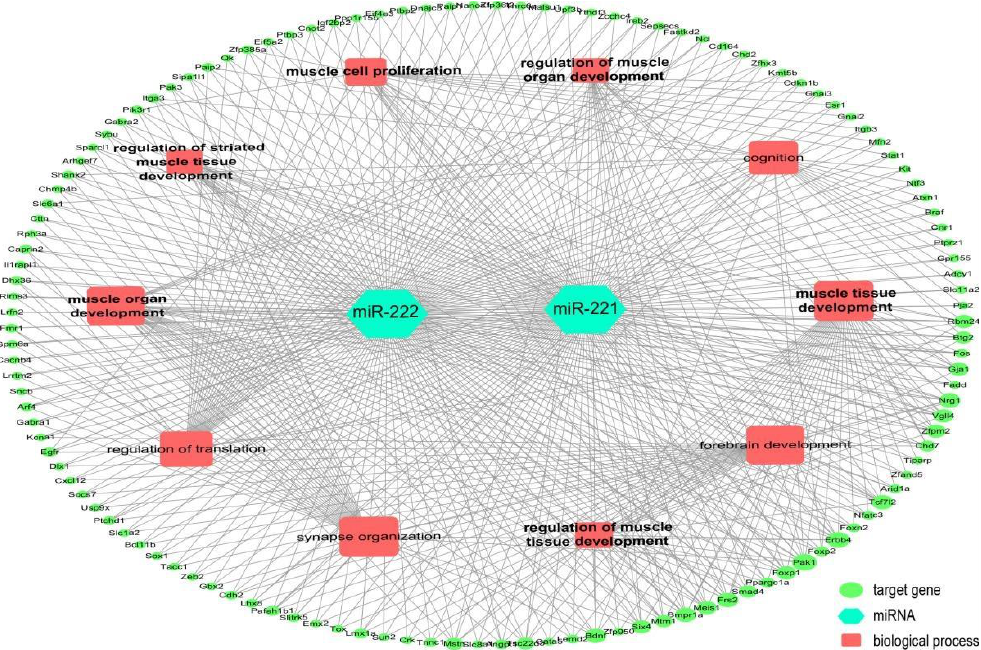
Figure 3. Regulatory networks reveal target genes of the miR-221/222 family and their involved biological processes.